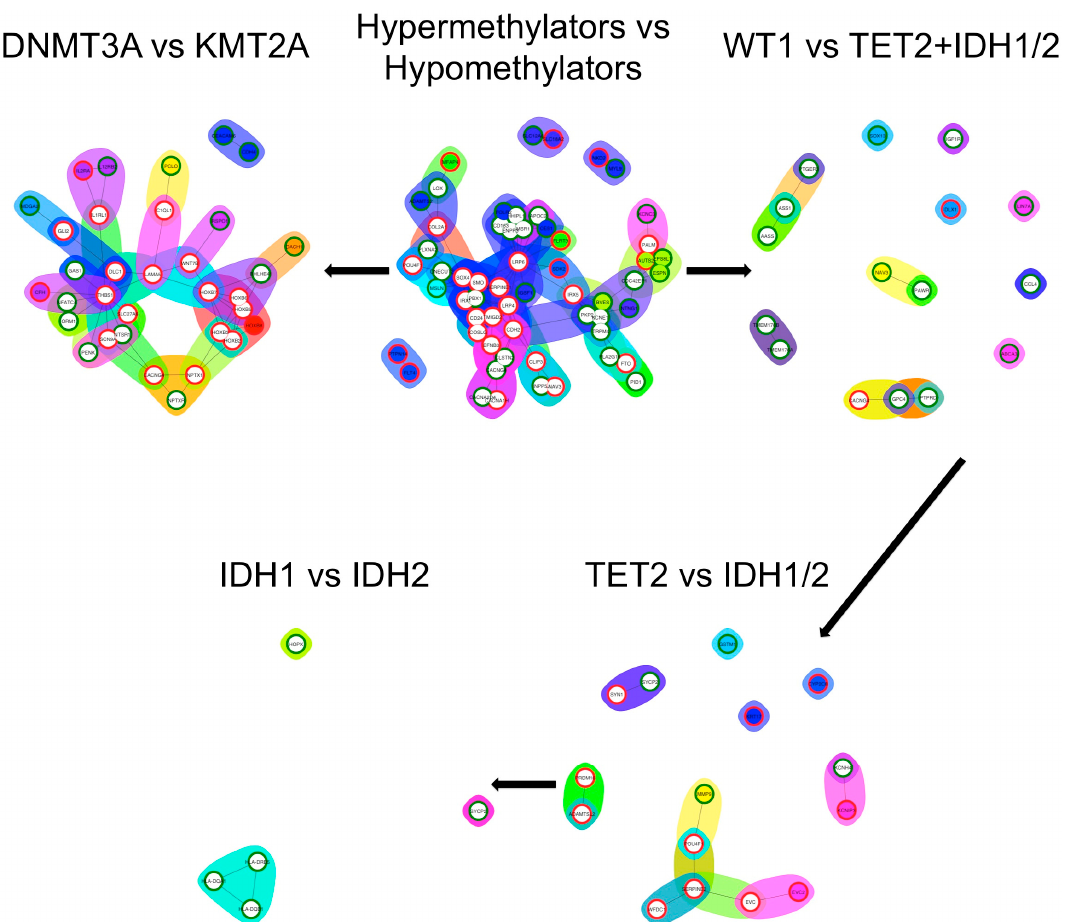
Figure 4. Functional network representation of the di ff erentially expressed genes between groups. The second group from the titles was always considered as the baseline. Upregulation was represented with red circles, while downregulation was represented with green circles.